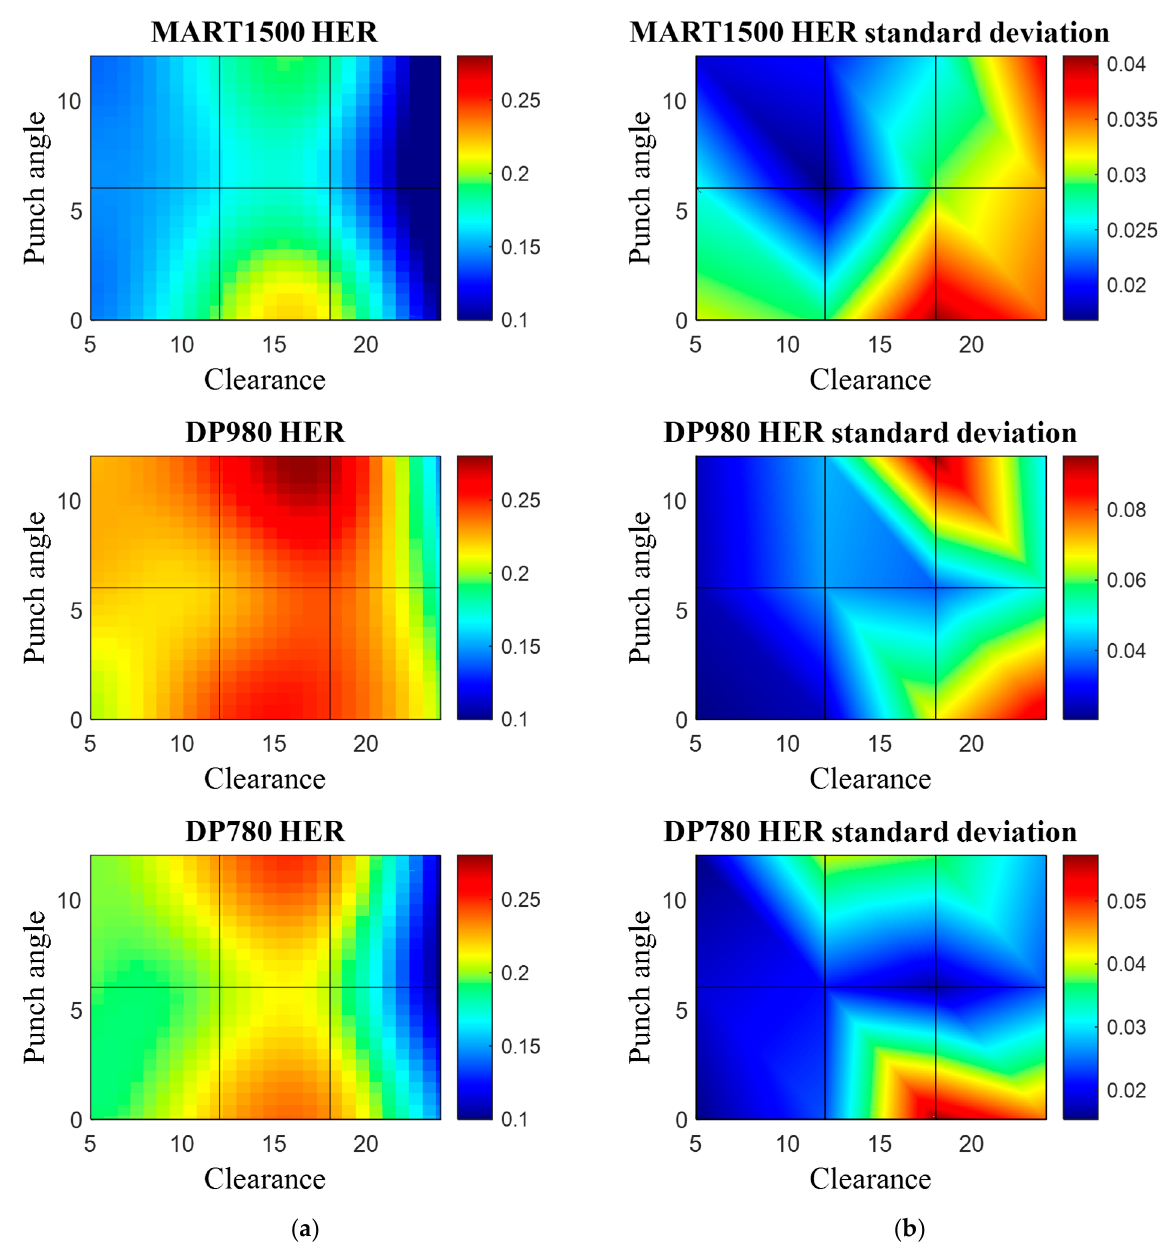
Figure 15. HET results with respect to punching parameter. ( a ) HER value with respect to material, clearance, and punch angle, fitted with GPR. ( b ) Standard deviation of HER with respect to each material, clearance, and punch angle.